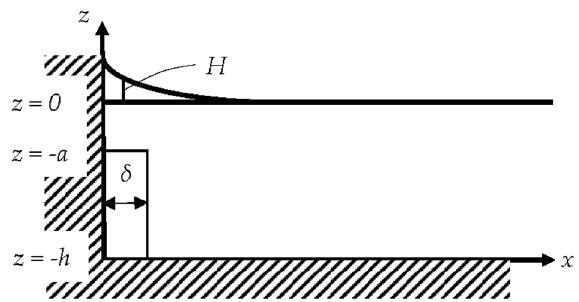
Figure 1. A plunging breaking wave approaches and hits violently the wall creating an air cavity of infinitesimal width δ ( z ) → 0. The wave propagates from right to left. The height of the liquid from the bottom, up to the undisturbed free surface before the impact is h .